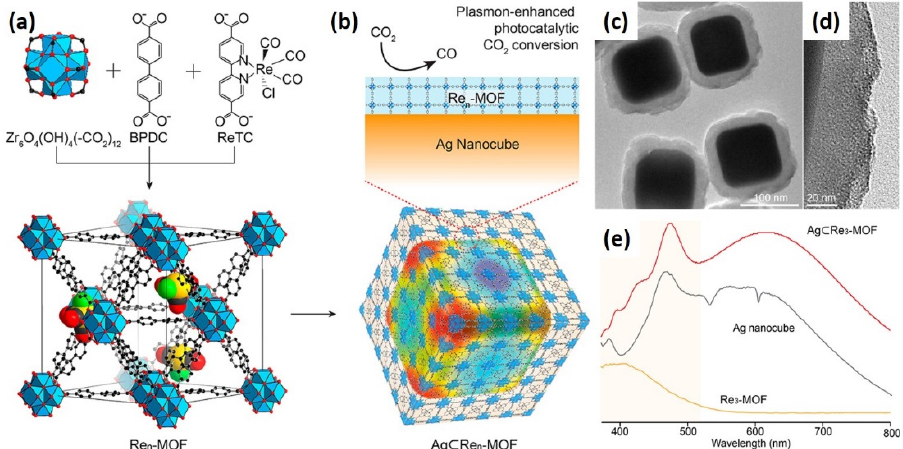
Figure 2. Structures of Re n ‐ MOF and Ag ⊂ Re n ‐ MOF for plasmon ‐ enhanced photocatalytic CO 2 conversion. ( a ) Zr 6 O 4 (OH) 4 ( − CO 2 ) 12 secondary building units are combined with 4,4 ′‐ biphenyldicarboxylate (BPDC) and ReTC linkers to form Re n ‐ MOF. The structure of Re 3 ‐ MOF is shown, as identified from single ‐ crystal X ‐ ray diffraction. The 12 ‐ coordinated Zr ‐ based metal clusters are interconnected with 21 BPDC and 3 ReTC linkers in a face ‐ centred cubic array. Atom labeling scheme: C, black; O, red; Zr, blue polyhedral; Re, yellow; Cl, green; H atoms are omitted for clarity. ( b ) Re n ‐ MOF coated on a Ag nanocube for enhanced photocatalytic conversion of CO 2 . ( c ) TEM image of Ag ⊂ Re 3 ‐ MOF, showing Re 3 ‐ MOF constructed on the surface of an Ag nanocube. ( d ) Magnified image of Re 3 ‐ MOF and ( e ) UV − vis spectra of the Re 3 ‐ MOF, Ag nanocube, and Ag ⊂ Re 3 ‐ MOF. Adapted with permission from [15]. Copyright 2017, American Chemical Society.